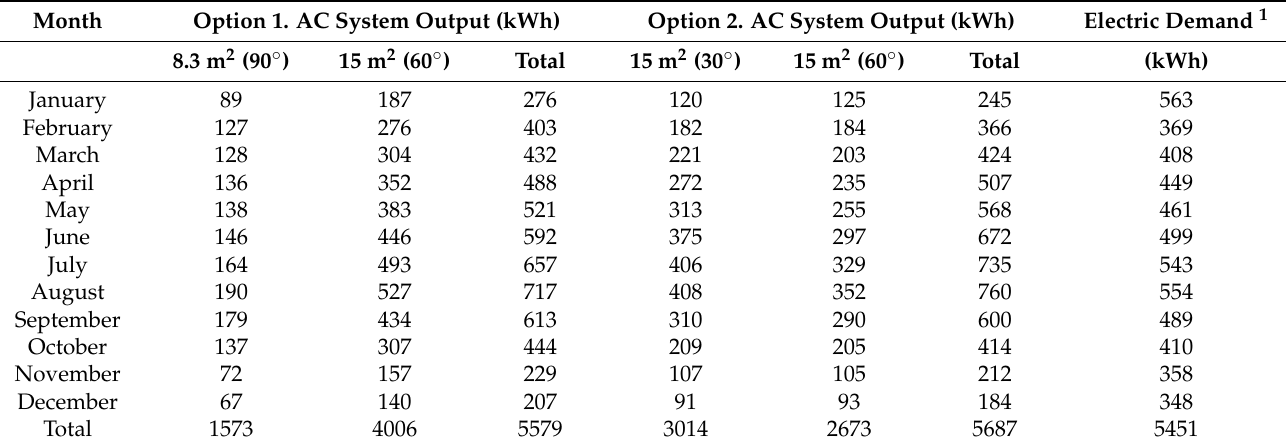
Table 5. Yearly water heat gain and heating loads for the WFG prototype.